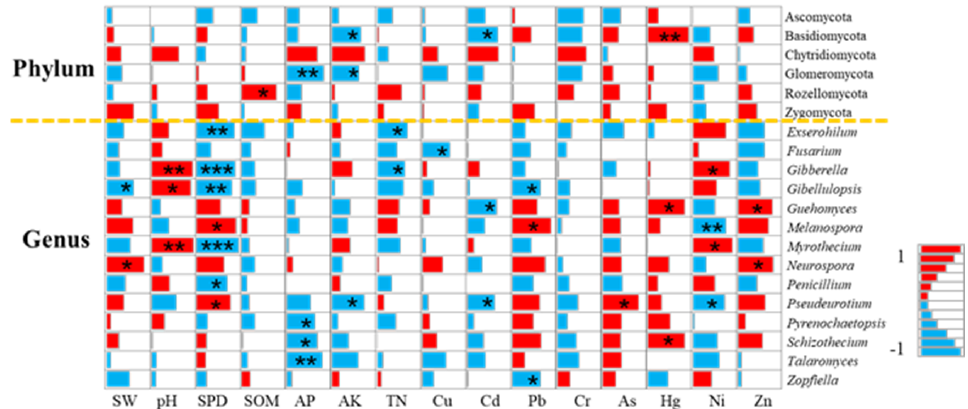
Figure 17. Correlation between soil environmental factors and fungal community structure at the level of heavy metal pollution. (Note: In the figure, warm colors indicate positive correlation, and cool colors indicate negative correlation. *, **, *** indicate significant correlation at the levels of 0.05, 0.01, and 0.001, respectively).